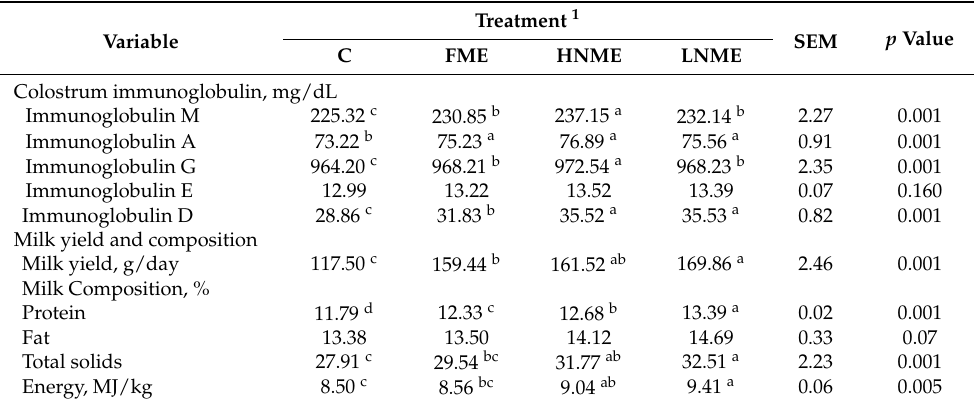
Table 3. Effects of free and nano-encapsulated Moringa oleifera leaf ethanolic extract (ME) supple- mentations on colostrum, milk yield and milk composition of multiparous rabbit does during the experimental period (mean ±